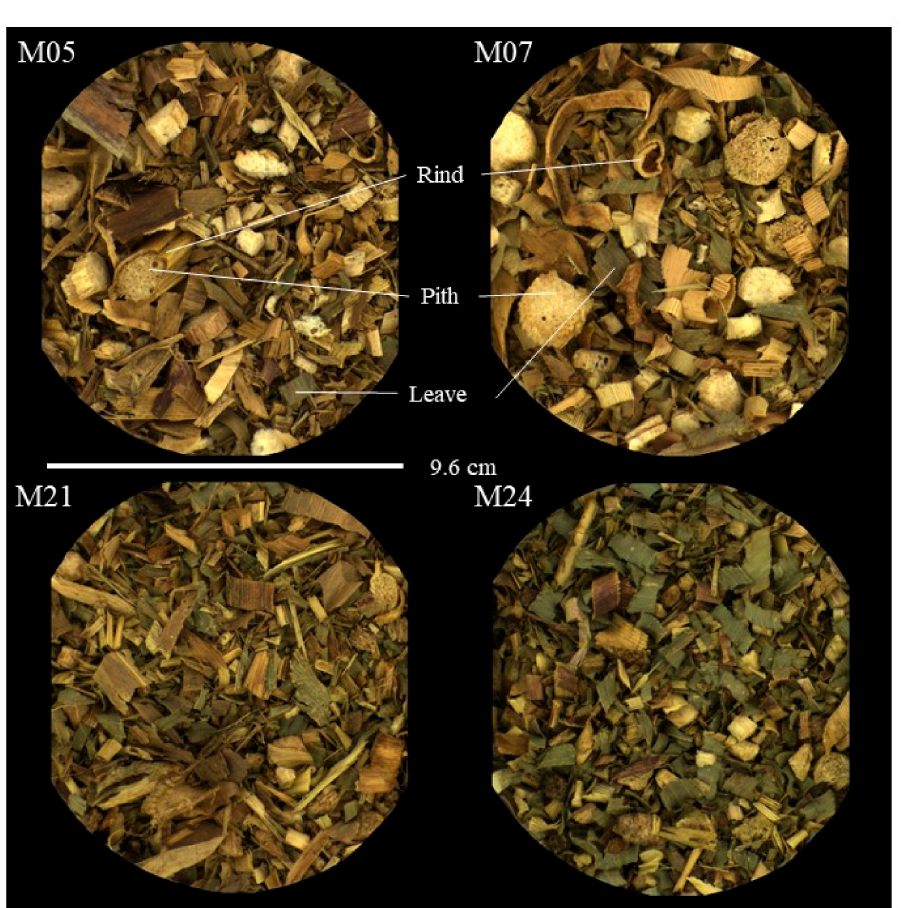
Figure 3. Light-box images chopped samples of four (M05, M07, M21 and M24) of the 24 inbred lines of maize. Field of view: 9.6 × 11.2 cm 2